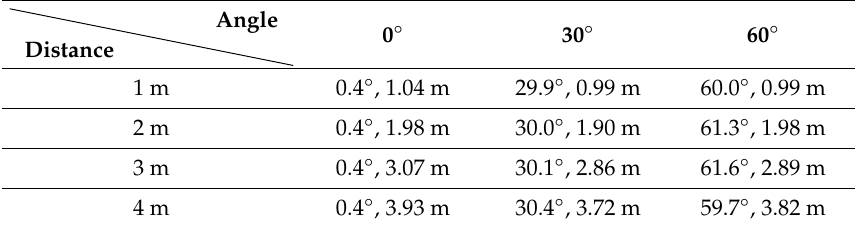
Table 1. Distance and angle measurements.